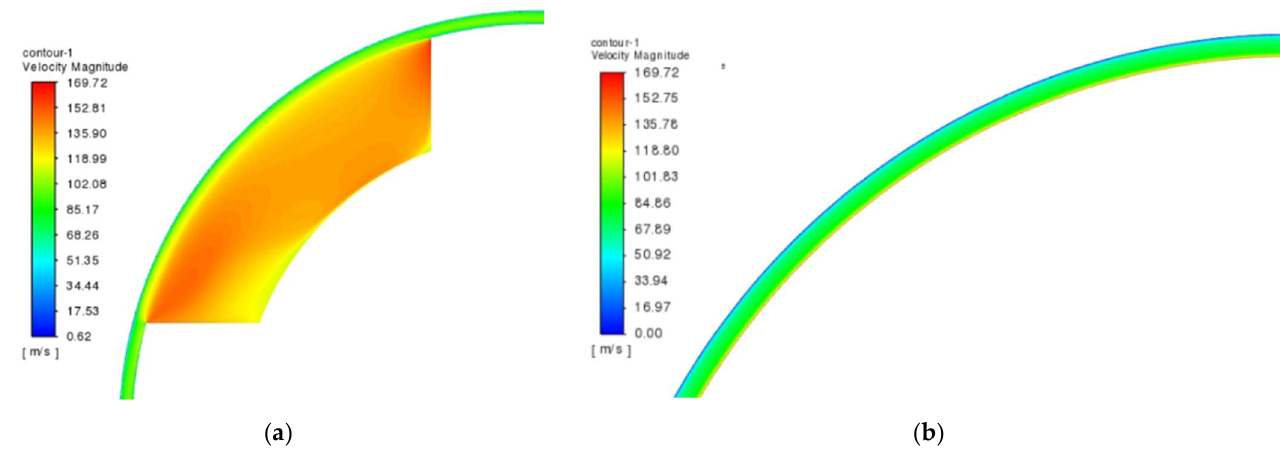
Figure 16. Velocity field contours inside the air gap at 100,000 rpm: ( a ) salient poles; ( b ) smooth cylindrical rotor.